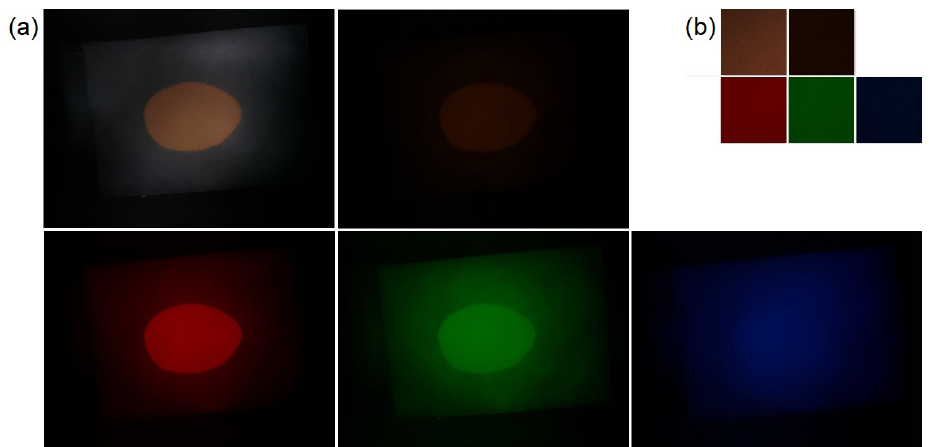
Figure 3. Image of the soil sample captured ( a ) and processing crop ( b ).